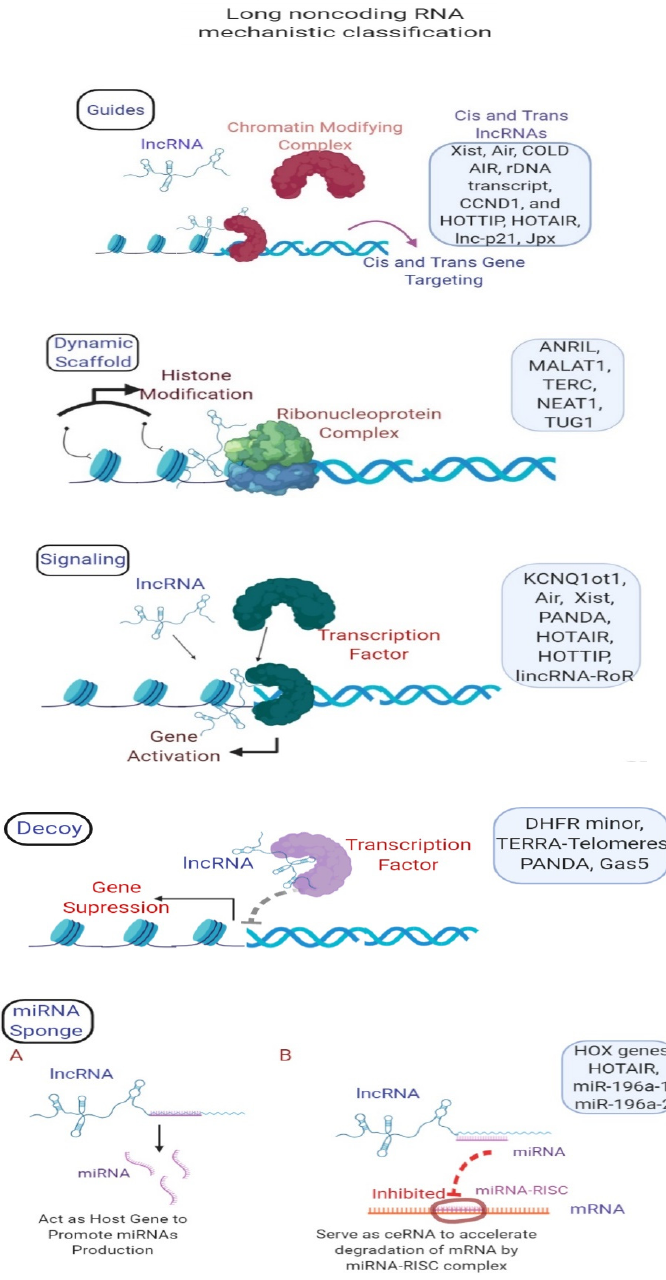
Figure 1. Long non-coding RNA mechanistic classification. Guides —long non-coding lncRNA interacts with enzymatically active or modifying complexes and directs them to a specific target. Dynamic Scaffolds —lncRNA serves as a central platform for multiple protein complexes and/or other cofactors directed to the specific genomic location. Signaling molecules —lncRNAs associated with specific signaling molecules for the activation of genetic and molecular pathways. Decoys —lncRNAs can bind to transcription factors or repressors to regulate gene activation and silencing. Micro (mi)RNA sponges —lncRNAs modulate miRNA expression; (A) they act as a host gene to promote miRNA production, and (B) they serve as competitive endogenous RNA (ceRNA) to accelerate the degradation of mRNA (messenger RNA) by the miRNA–RISC (RNA-induced silencing complex) complex. (Figure made using BioRender (https: // biorender.com /